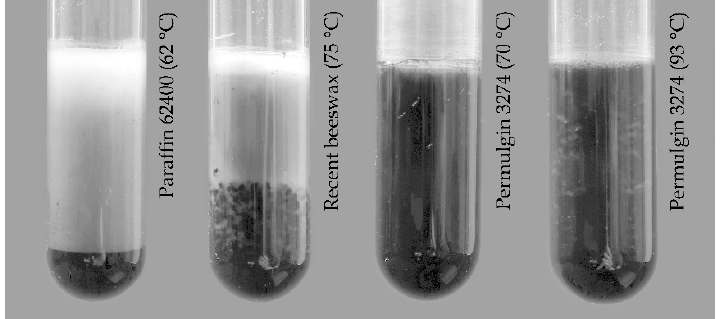
Figure 9. Comparison of sedimentation extent of pigments in molten waxes at different temperatures after 20 min. Used temperatures are 10 °C higher than melting temperature/drop point.